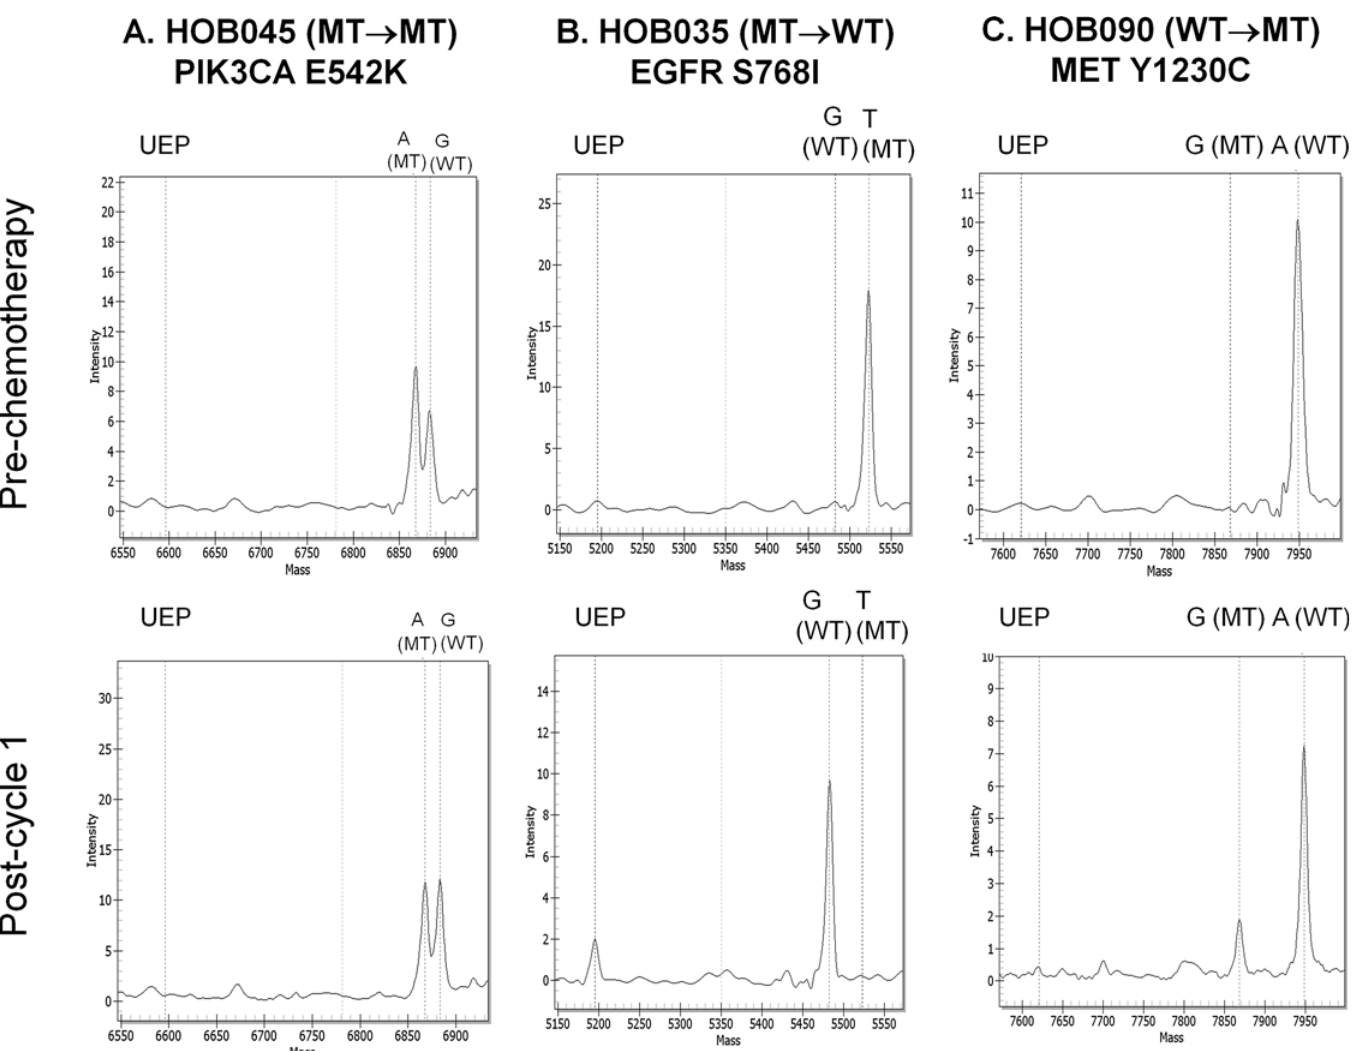
Fig 2. Oncogenic mutations detected pre- and post-chemotherapy. Representative chromatograms of (A) PIK3CA E542K in a MT ! MT case HOB045, (B) EGFR S768I in a MT ! WT case HOB035, and (C) MET Y1230C detected in a WT ! MT case HOB090. The expected positions for the unextended primer (UEP) and the nucleotide and mutation status (mutant [MT] or wildtype [WT]) based on the size of the extension products are indicated above the gray vertical dashed lines.